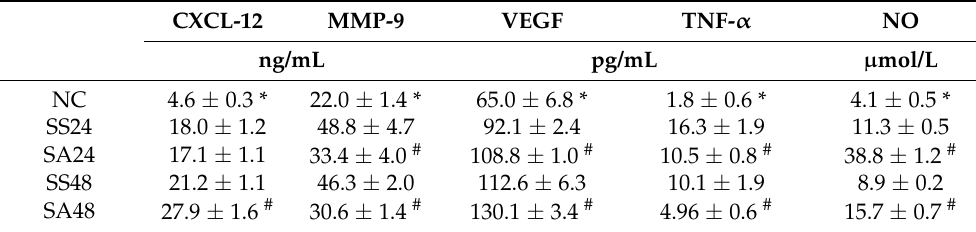
Table 1. The expression of endothelial progenitor cell (EPC) mobilizing factors in plasma.